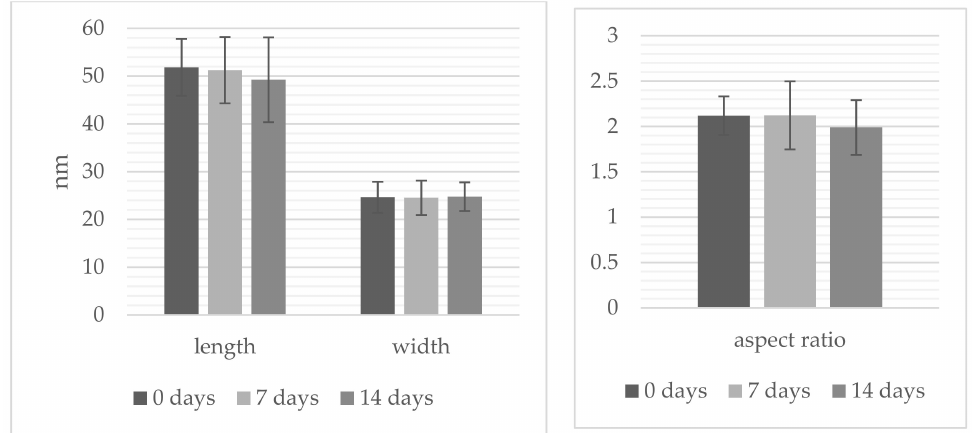
Figure 6. Time dependent morphological changes of studied